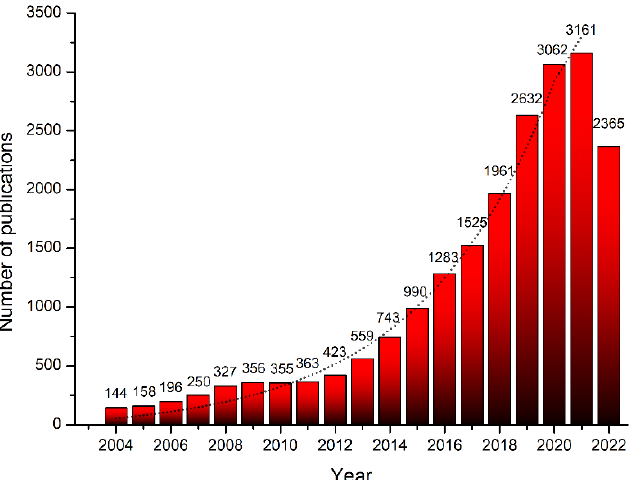
Figure 1. Trend of published papers related to CDs since their discovery. (Obtained using Scopus search results for “Carbon Dot”).